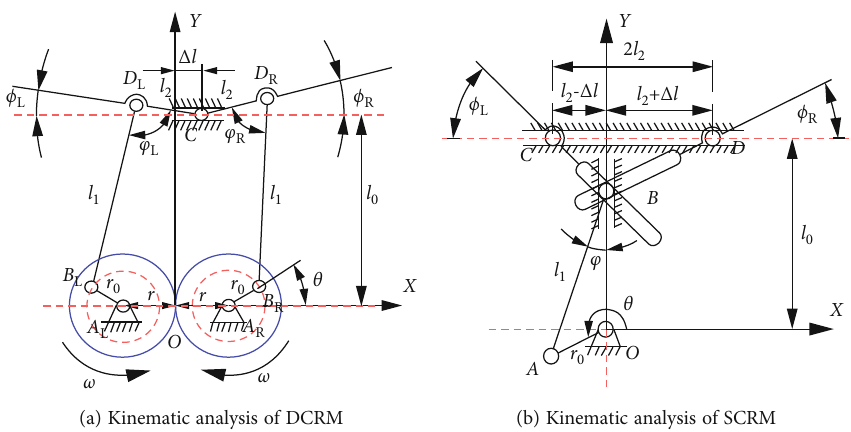
Figure 2: Diagram of kinematic analysis. Table 1: Lengths of all parts in the DCRM and the